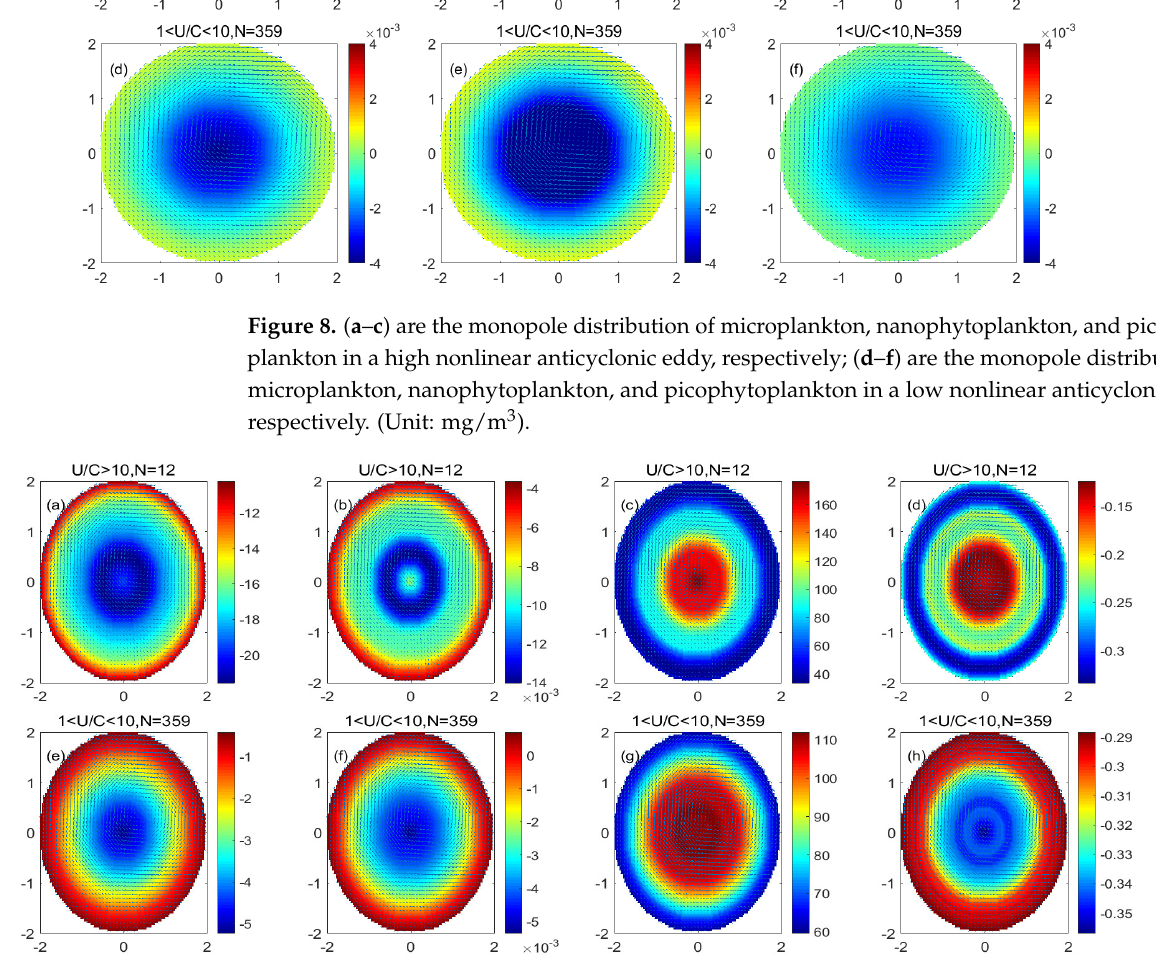
Figure 9. ( a − d ) are the monopole distribution of the PP variation, POC variation, PP/Chl, and PP/POC in the high nonlinear anticyclonic eddy, respectively; ( e − h ) are the monopole distribution of the PP variation, POC variation, PP/Chl, and PP/POC in the low nonlinear anticyclonic eddy, respectively. (Unit: mg/m 3 ).